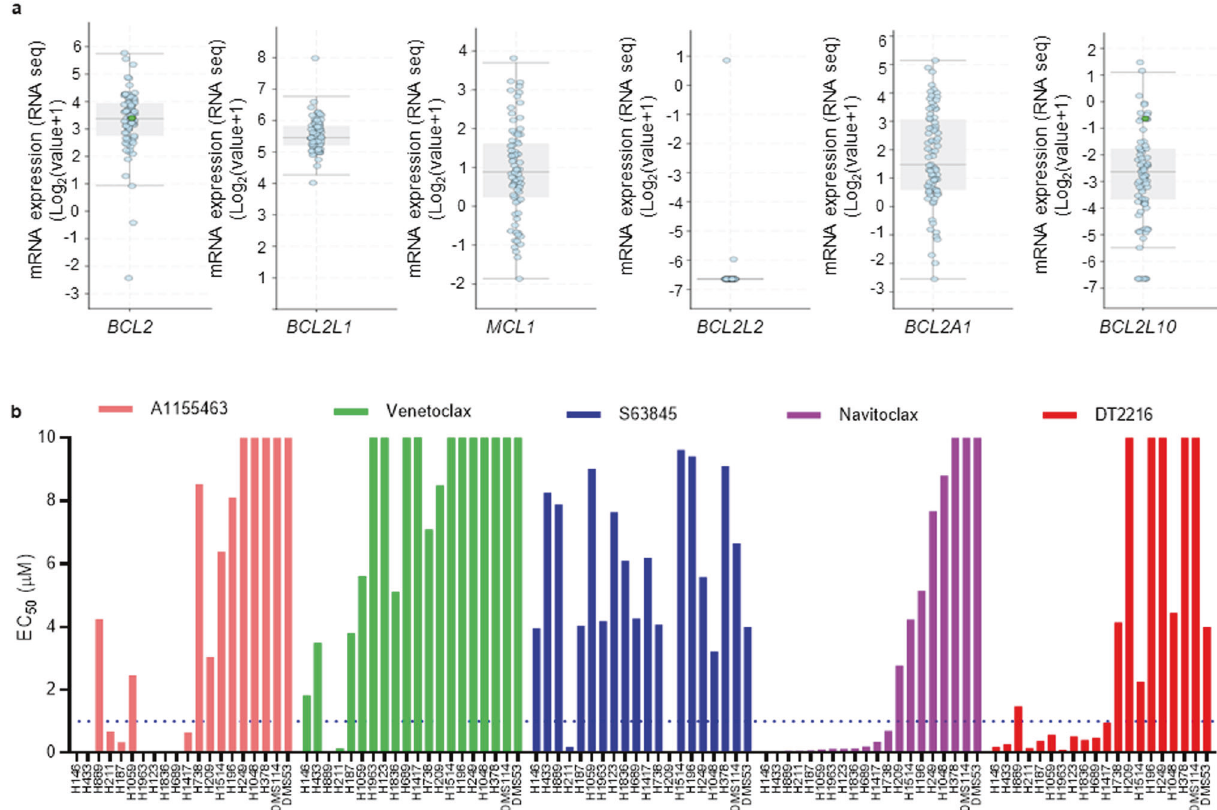
Fig. 1 The SCLC cell lines show differential survival dependence on BCL-2 family proteins. a The mRNA expression of BCL2 family anti- apoptotic genes as obtained from U Cologne study via cBioPortal. The mRNA expressions are depicted as Log2 (value + 1) from the RNA sequencing (RNA seq) dataset ( n = 81 patient samples). b The EC 50 values of A1155463 (a selective BCL-X L inhibitor), venetoclax (a selective BCL-2 inhibitor), S63845 (a selective MCL-1 inhibitor), navitoclax (a BCL-X L /BCL-2 dual inhibitor) and DT2216 (a selective BCL-X L PROTAC degrader) were derived from % viability of indicated human SCLC cell lines after they were incubated with increasing concentrations of these inhibitors for 72 h. The data are presented from a single experiment performed in three replicate cell cultures. Similar results were obtained in two additional experiments performed with H146 and H378, and one additional independent experiment performed with H187, H211, and H209 cell lines. When an inhibitor showed an EC 50 of ≤ 1 μ M in any given cell line, the cell line was considered as sensitive to that inhibitor and dependent on its target BCL-2 family